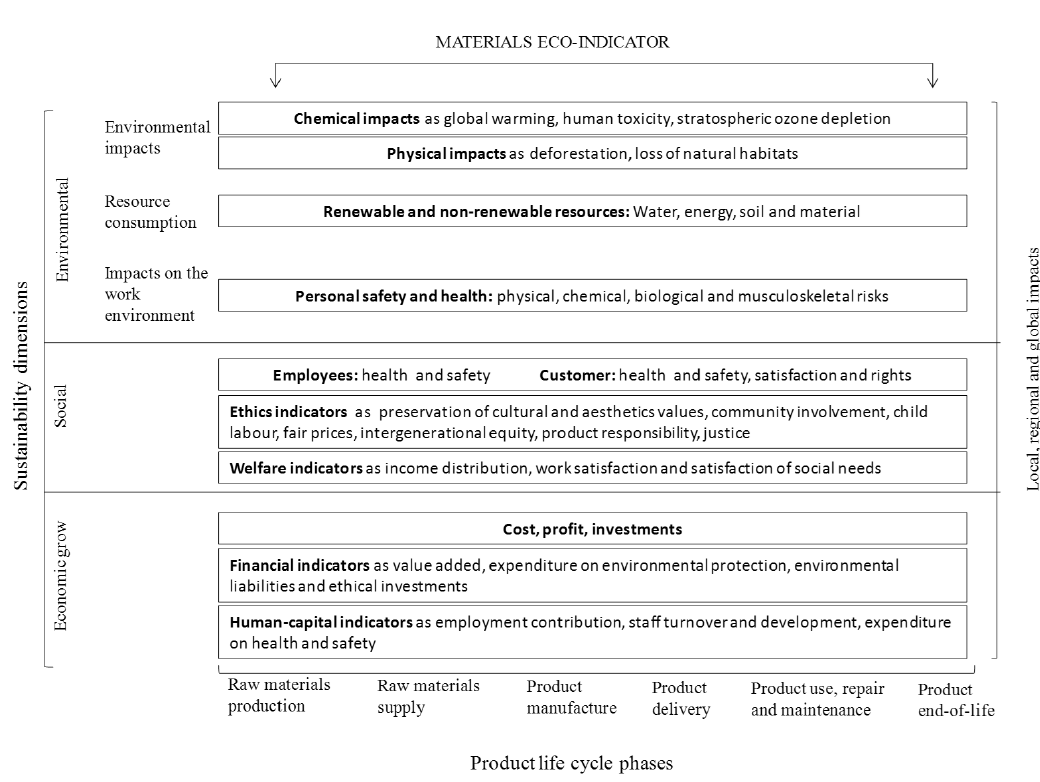
Figure 2: Materials eco-indicator determined by its impact on the product life cycle phases 8,12,47,48